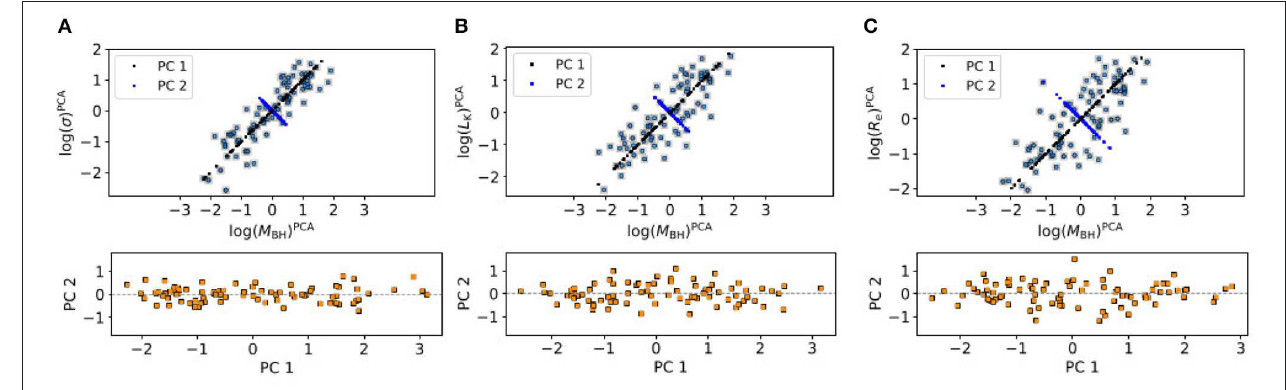
FIGURE 4 | Upper panels: the orientations of the mutually orthogonal eigenvectors resulting from our 2D-space PCA are drawn onto the log( M BH ) PCA -log( σ e ) PCA (A) , log( M